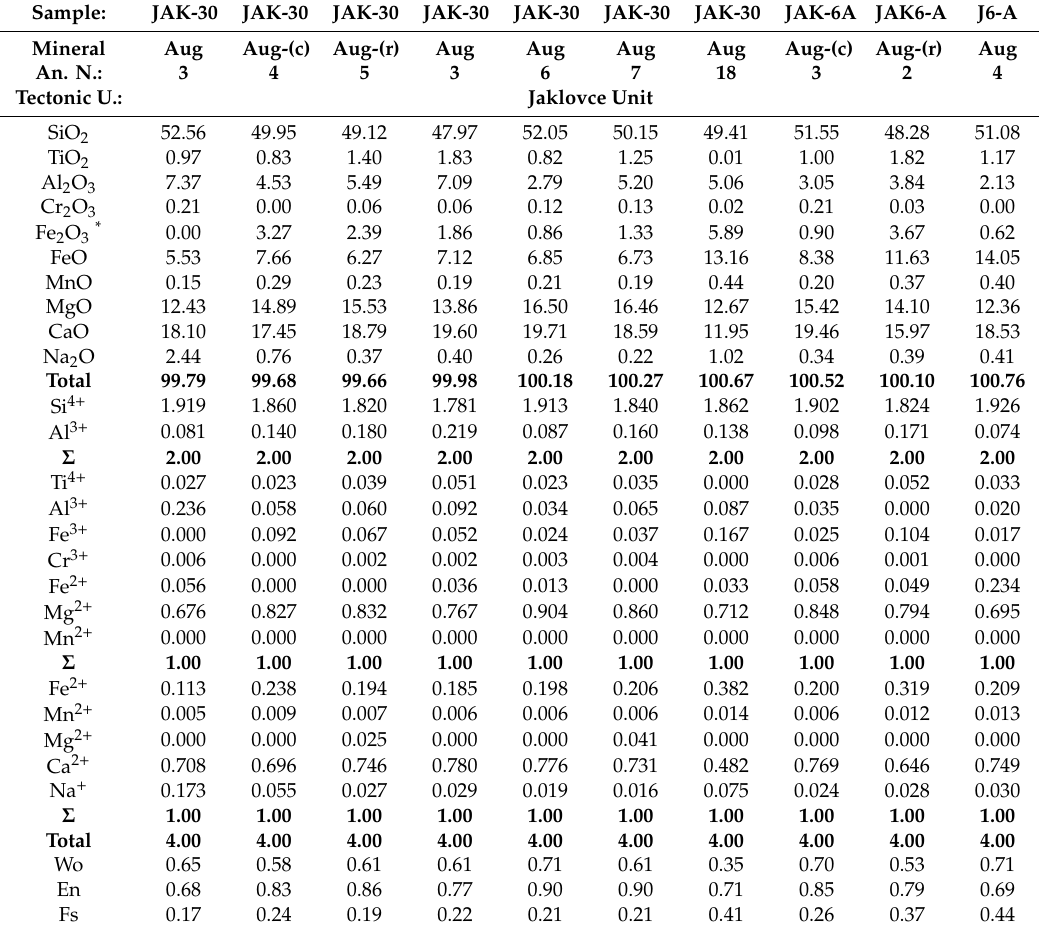
Table 1. Representative analyses of augitic clinopyroxene from the Jaklovce